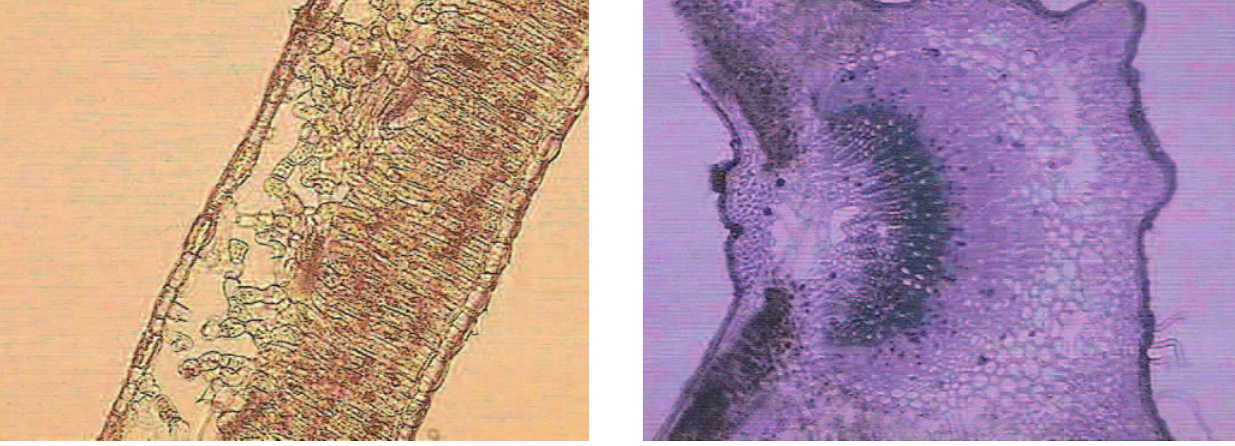
Figure 1. In the assortment without irrigation, cross section of leaf blades of Ozark Gold the large intercellular space is seen (magnification 10×)